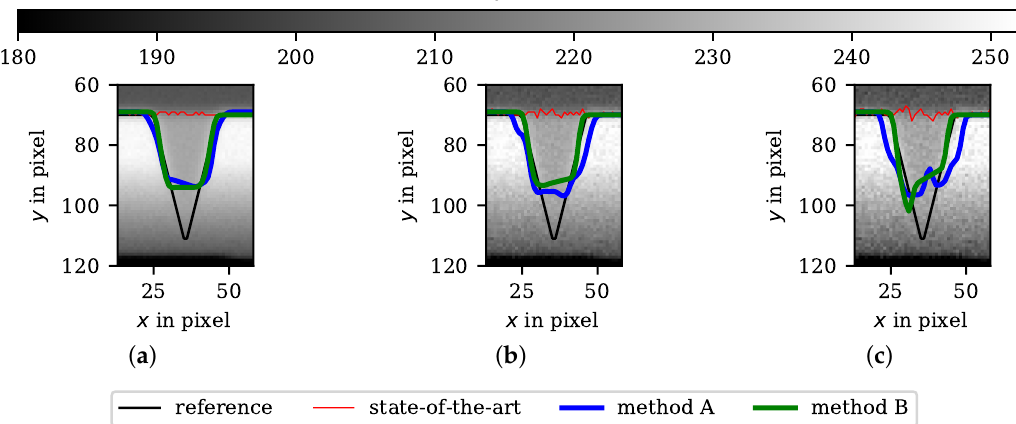
Figure 10. Simulated thermographic flow visualization image with premature flow transitions along the flanks of a turbulence wedge with a relative contrast of c wed = 50%. The relative noise amplitude is ( a ) 0.1, ( b ) 1.0, and ( c ) 1.5 times the measured image noise in a real, reference image. The corresponding CNR are 496, 73, and 33, respectively. Increasing noise results in more local gradient maxima falsely interpreted as premature flow transitions. The consequence is an increased uncertainty of the flow transition line for method A (blue) and B (green).